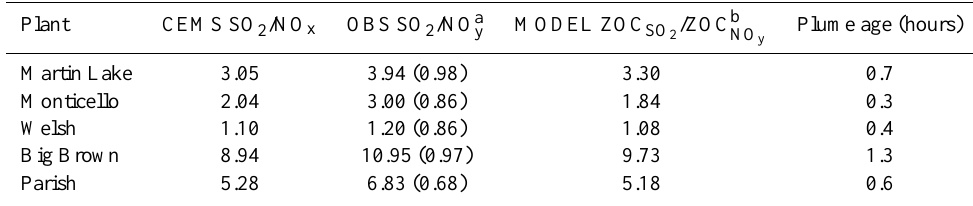
Table 2. CEMS-reported E(SO 2 )/E(NO x ) emission molar ratio, the observed SO 2 /NO y and the modeled ZOC SO of the first plume